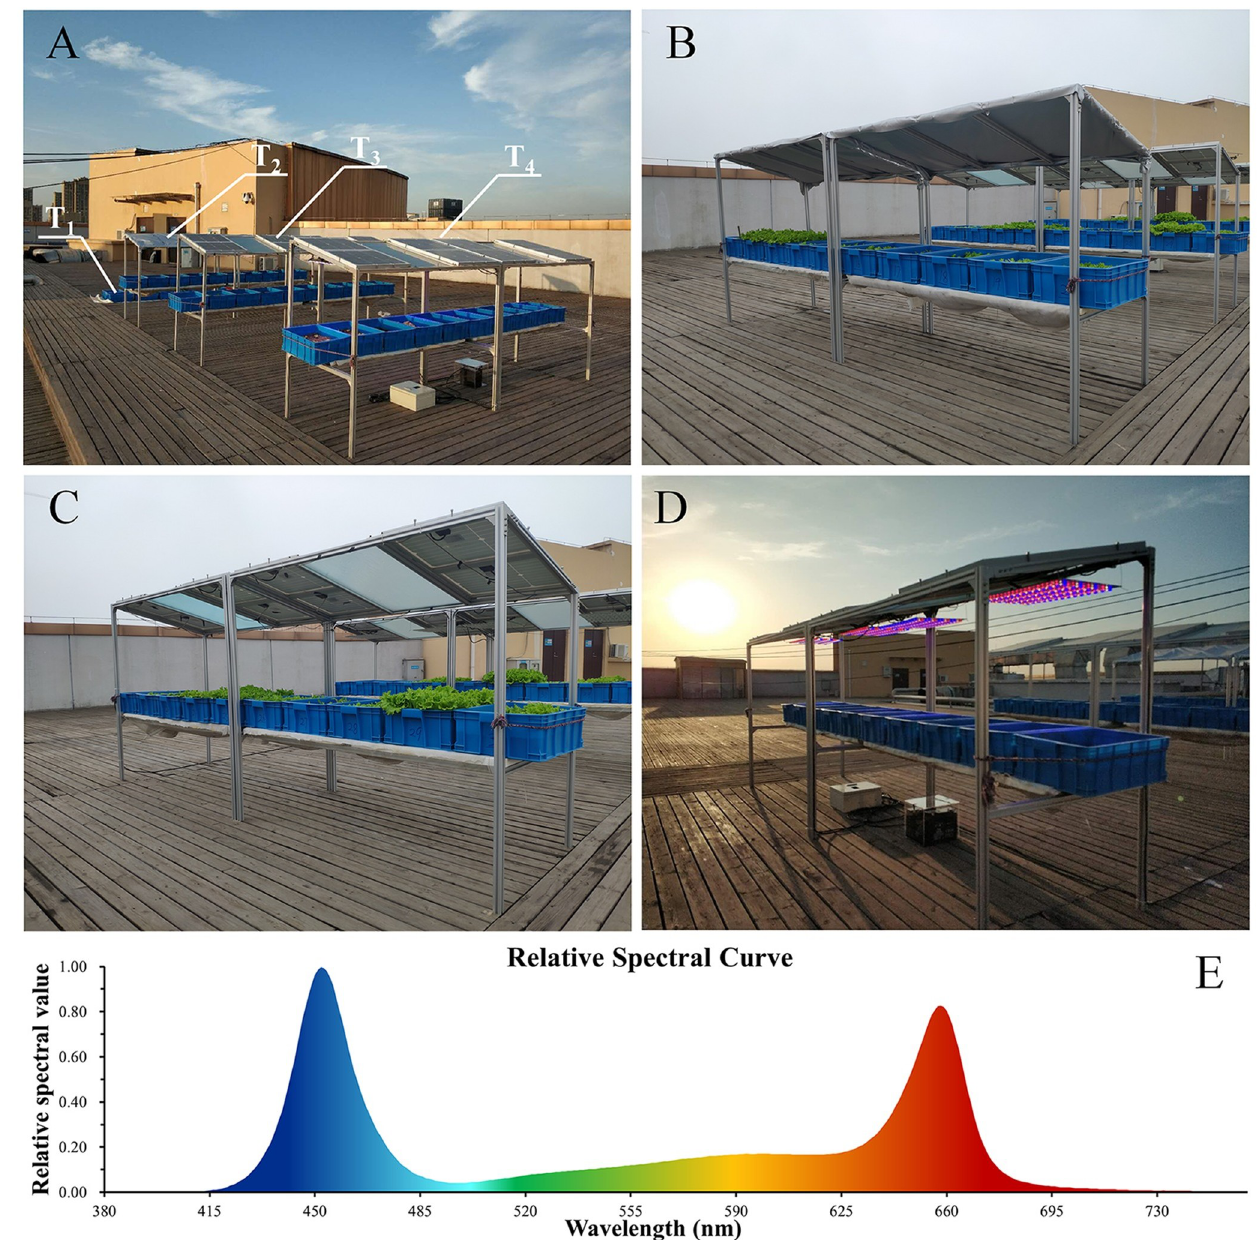
Fig 3. Photographs of the small-scale experimental facilities of the four treatments (T 1 , T 2 , T 3 , T 4 at IAT, USTC, Hefei of Anhui, China). Overall photograph of the four treatments (A). Photograph of T 2 (The shading cloth was used to simulate the shading effect of PV panels whose shading effect is the same as the PV panels after testing.) (B). Photograph of T 3 (C). Photograph of T 4 (The supplementary LED lamps were turned on to show and test the system function.) (D). The light spectrum of the supplementary LED lamps